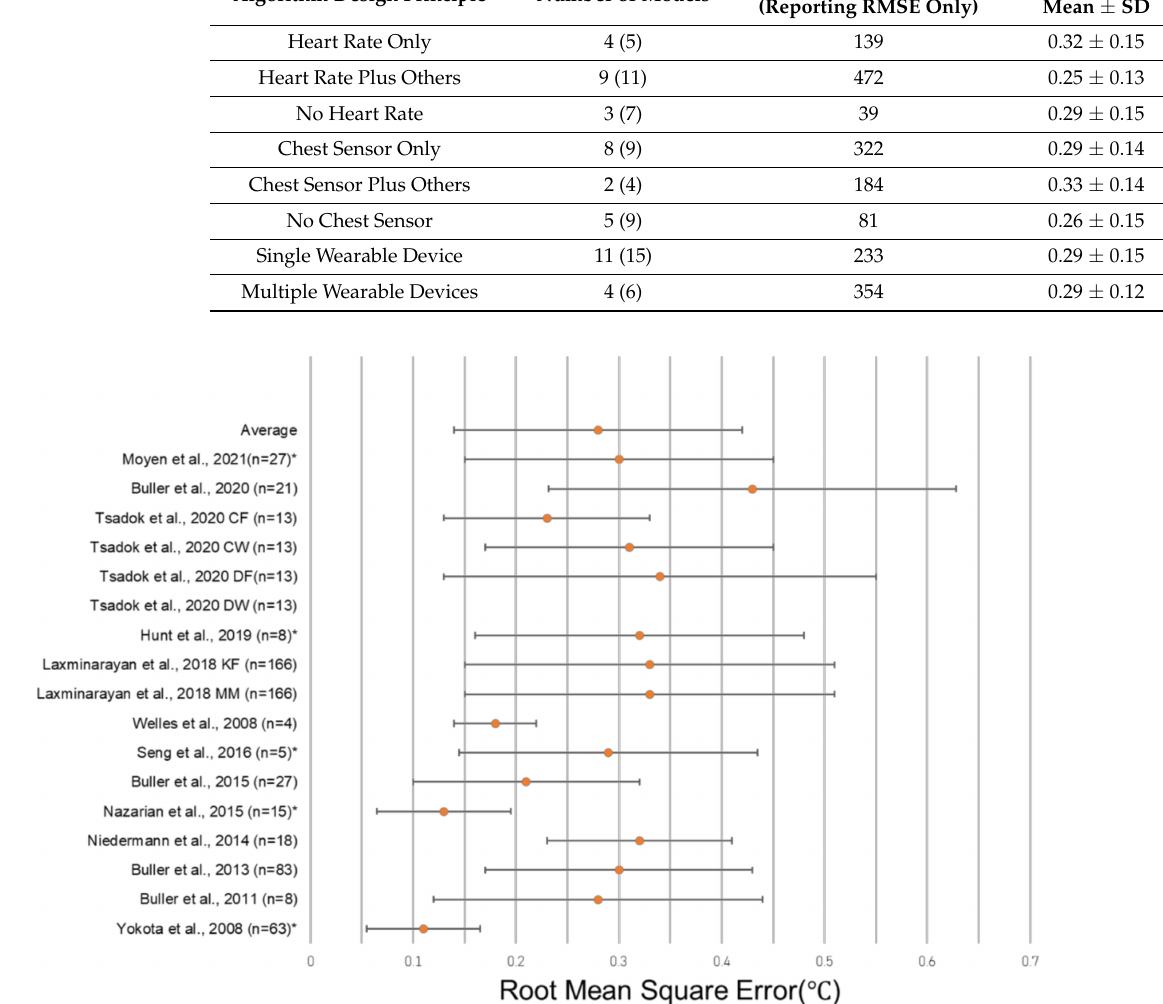
Figure 4. Forest plot depicting the RMSE ± standard deviation of studies reporting this metric. Tsadok et al. DW [47] is excluded both from the plot and from the displayed average due to its status as an outlier. The asterisks (*) denote models that did not report a RMSE SD, and so, the error bars represent ± 1 of the reported RMSE. 2